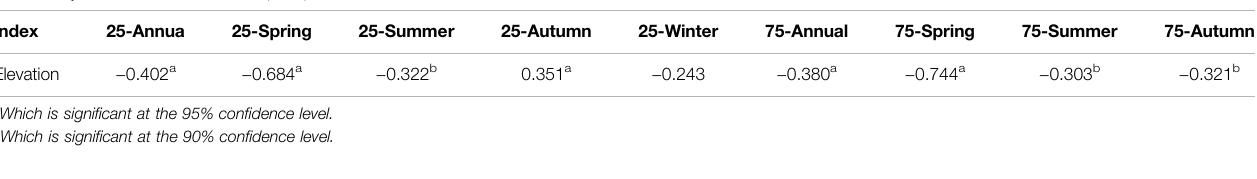
TABLE 6 | The correlation between precipitation index and altitude.